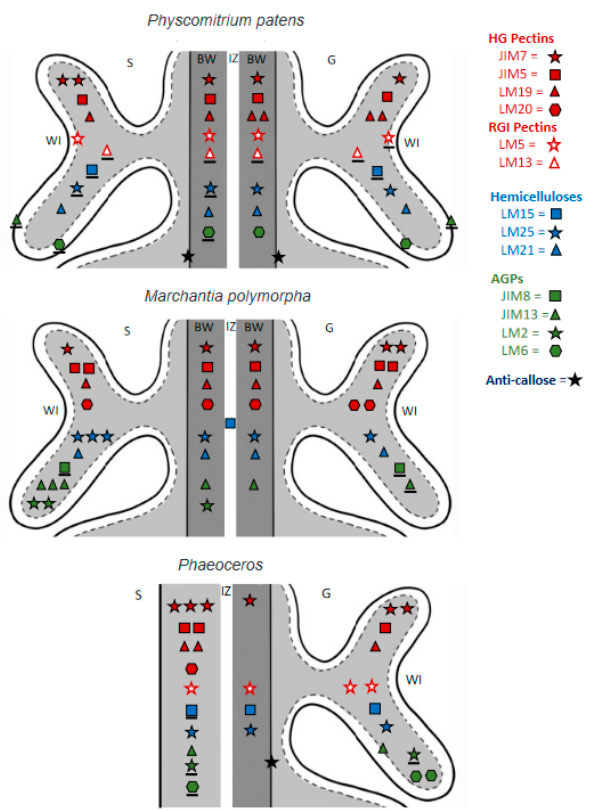
Figure 6. Comparative diagrammatic representation of labeling with 14 MAbs to epitopes of cell wall polymers in three bryophyte placentae: the moss Physcomitrium patens (this study), liverwort Marchantia polymorpha [18], and two species of Phaeoceros [5]. The LM28 and LM12 MAbs yielded no labels in any plant. LM13 labeling in Phaeoceros was inconclusive and omitted. Note: pectins, red; hemicellulose, blue; AGPs, green; callose, black. The number of symbols per MAb corresponds to label intensity as follows: three symbols, very strong; two symbols, strong; one symbol, weak; underlined symbol, present but rare. S = Sporophyte, G = Gametophyte, IZ = Intergenerational zone, WI = Wall